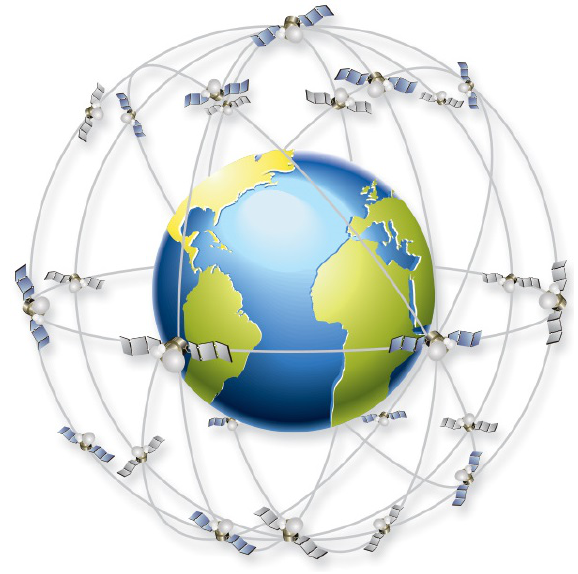
Figure 2. Global Positioning System (GPS) requires a minimum of 24 satellites [31] generic satellite constellation that seamlessly integrates